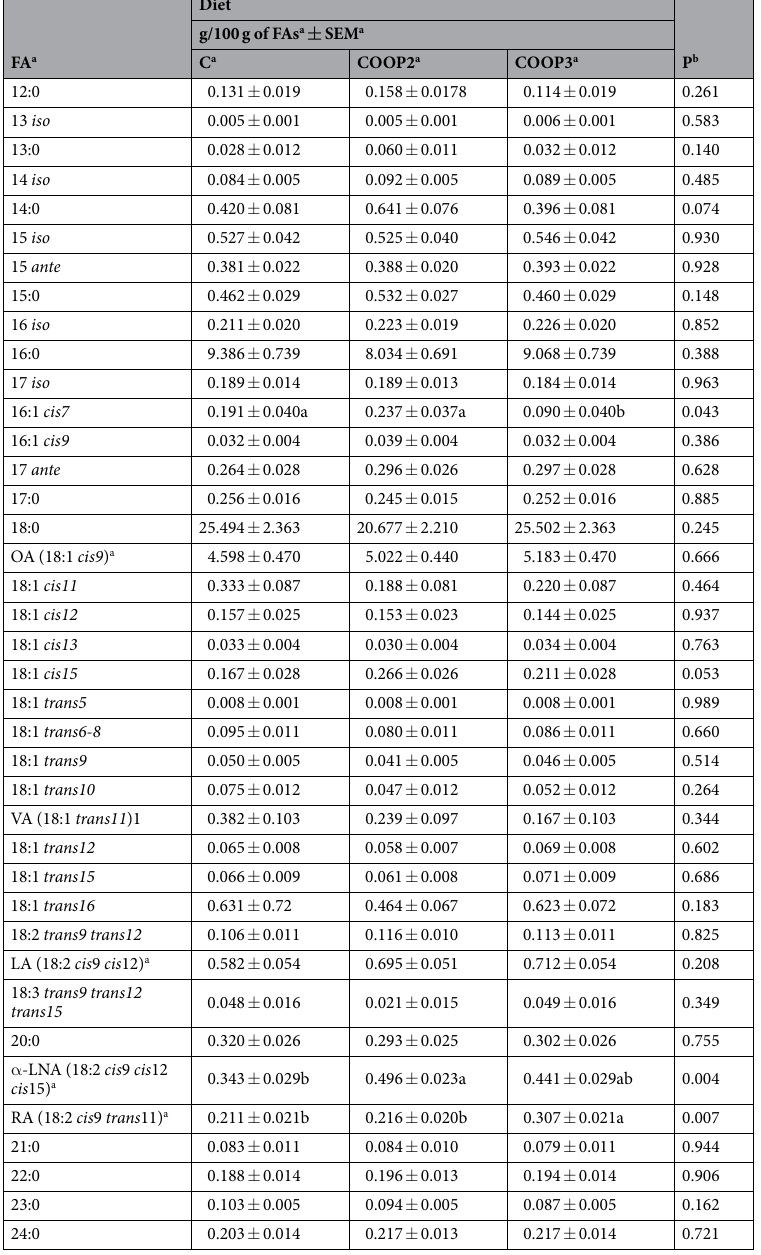
Table 1. Effect of olive oil pomaces on FA a production in rumen liquor. a Acronyms used in this table: FA (fatty acid), C (control diet), COOP2 (control diet added with olive oil pomace extracted with a two-phase procedure), COOP3 (control diet added with olive oil pomace extracted with a three-phase procedure), OA (oleic acid), VA (vaccenic acid), LA (linoleic acid), α -LNA ( α linolenic acid), RA (rumenic acid) and SEM (Standard Error Mean). b Probability of significant effect due to experimental diets; means within a row with different letters differ (P <